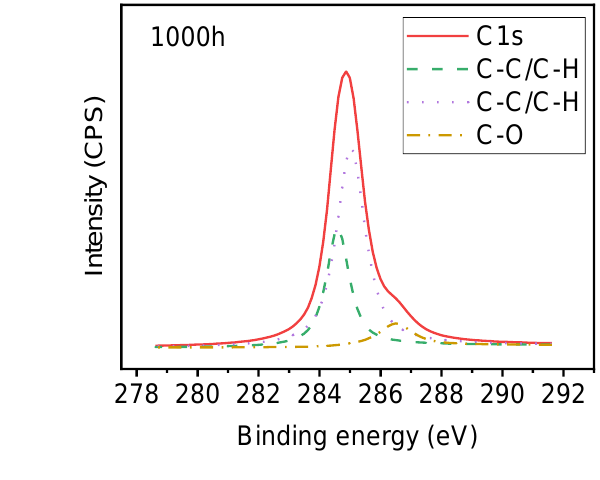
Figure 13. Peak fitting of C in alicyclic epoxy resin samples.